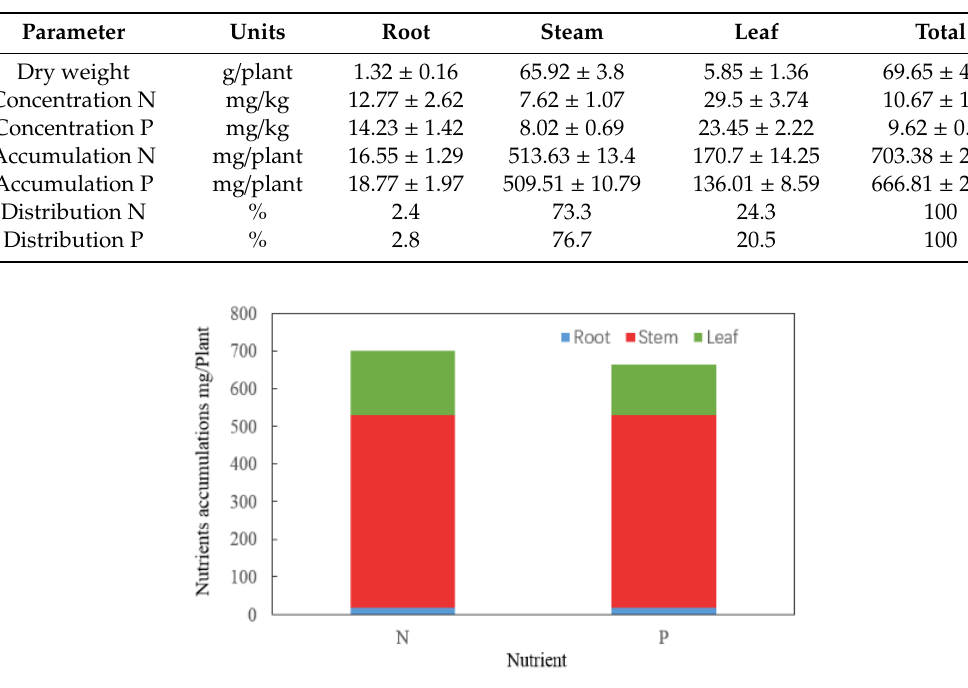
Figure 5. The nutrient distribution in shrub willow ( Salix spp .). Table 2. The plant growth and nutrient contents in the leaves, stems, and roots of shrub willow ( Salix spp. ).